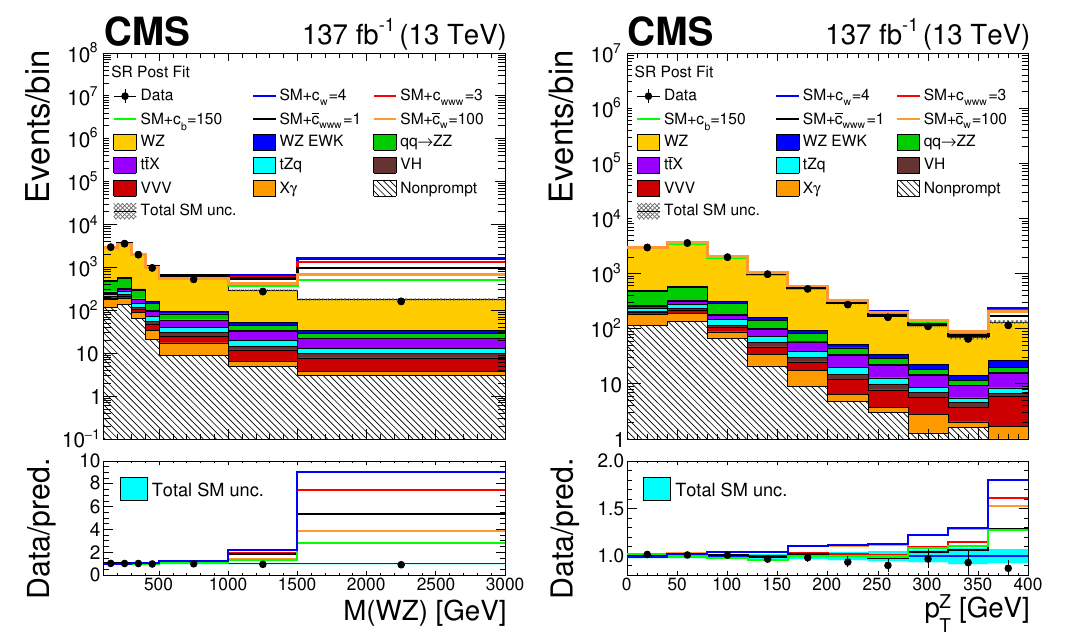
Figure 18 . Distribution of observables in the SR, comparing SM distributions and several possible configurations of EFT parameters after the fit to the SM-only model. Left: invariant mass of the WZ system assuming a neutrino with no longitudinal momentum ( M (WZ) ); right: transverse momentum of the reconstructed Z boson. The SM contributions are shown as the stacked filled histograms, while each of the individual coloured lines shows the expected SM yields plus the contributions from a possible configuration of EFT parameter values. Observed data is shown in black points, with vertical bars representing their statistical uncertainties. The ratio shows the quotient between the BSM contributions and the nominal SM yields. The label X g includes Z g , W g , tt g , and WZ g production. The label ttX includes ttZ , ttW , and ttH production. The shaded band in the ratio presents the total uncertainty in the SM yields. Underflows (overflows) are included in the first (last) bin shown for each distribution. The distribution of the transverse momentum of the Z boson is not used in the BSM interpretation of the analysis and is shown just for illustration.